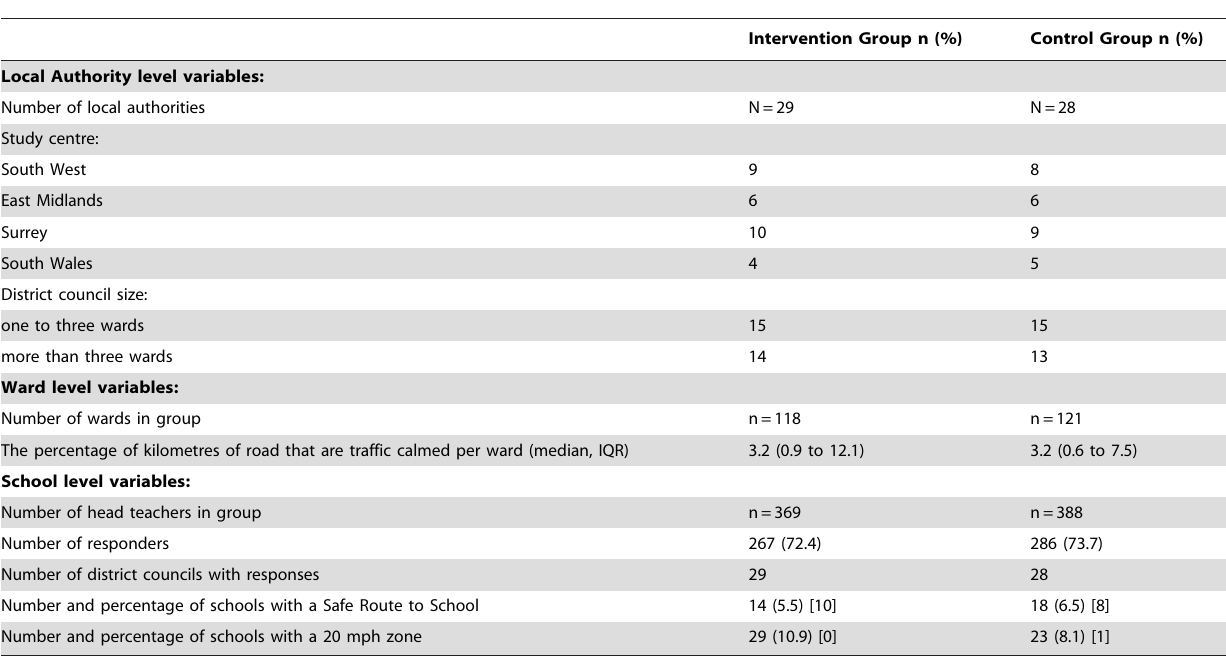
Table 3. Baseline characteristics of treatment groups. Values are numbers and % unless stated otherwise.